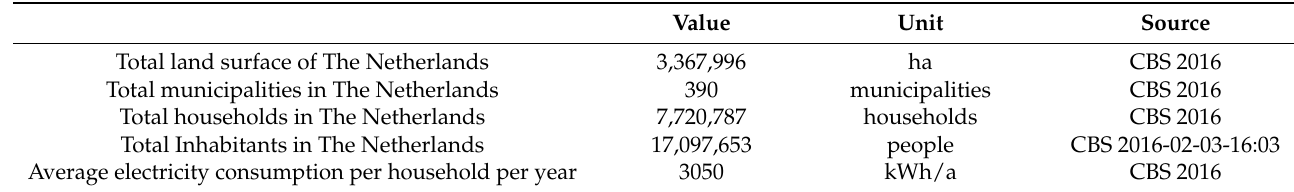
Table A1. Main data of The Netherlands.